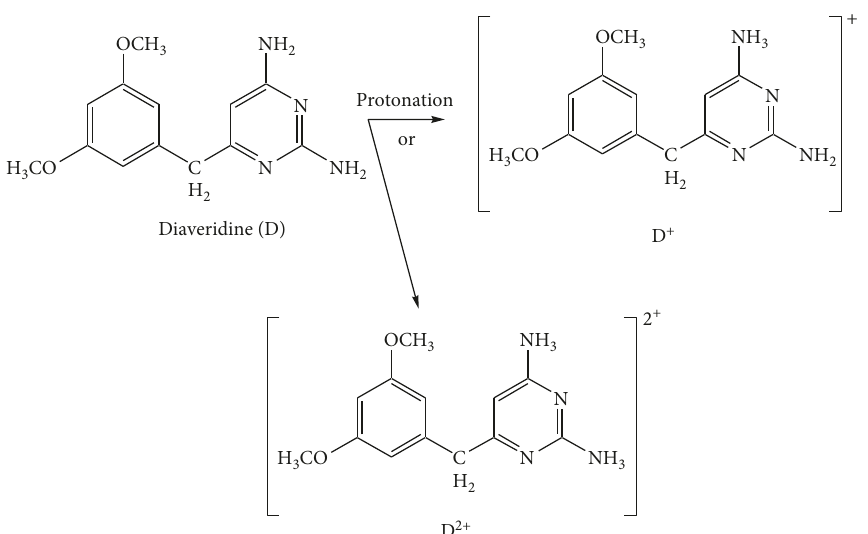
Scheme 2: Positively charged protonated forms of